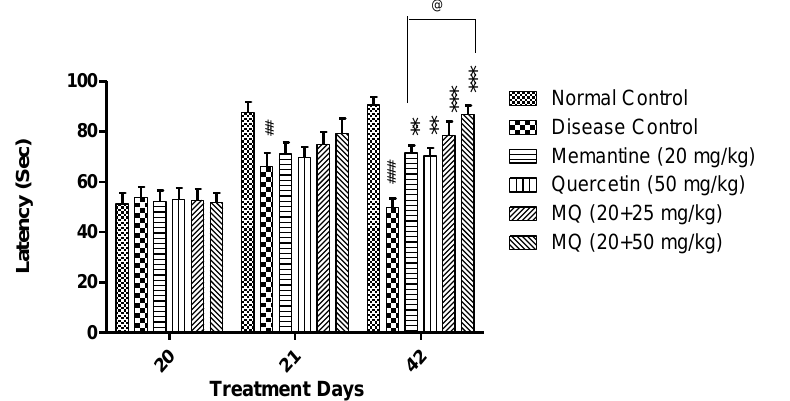
Figure 4. Effect of quercetin and quercetin with memantine on escape latency in AlCl 3 -induced neurotoxicity in rats. Data are expressed as mean ± SEM ( n = 6), ## p < 0.01, ### p < 0.001 when compared with the normal control group, ** p < 0.01, *** p < 0.001 when compared with the disease control group, and @ p < 0.05 with the memantine-treatment group. AlCl 3 : aluminum chloride; SEM: standard error of mean.